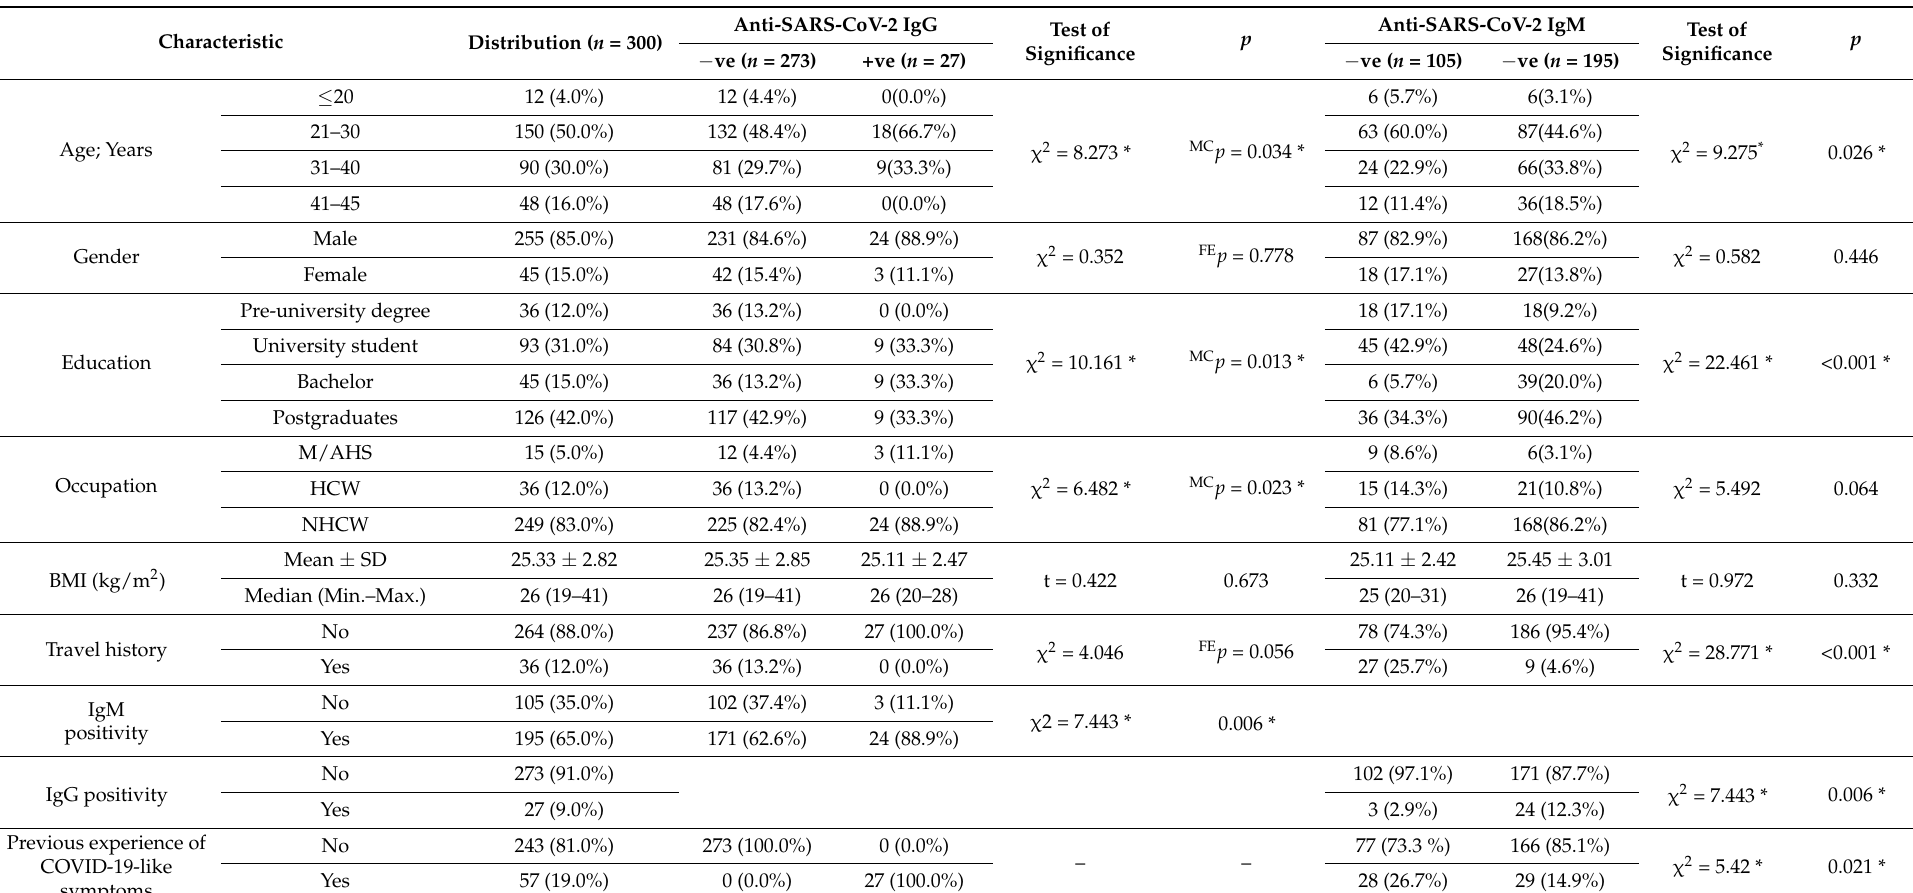
Table 1. Comparison of the demographics, lifestyle, and anthropometrics of blood donors stratified for the extent of anti-SARS-CoV-2 IgG or anti-SARS-CoV-2 IgM in their plasma (Total n = 300). Data shown are frequencies; n (%), and mean ± SD (median;